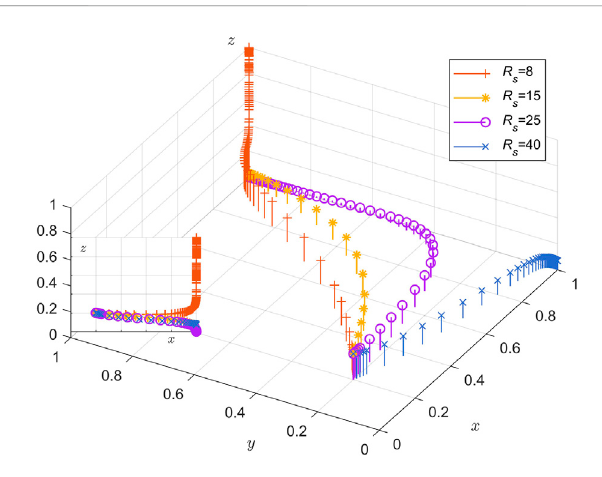
FIGURE 12 The impactofrevenue Rs on theevolution